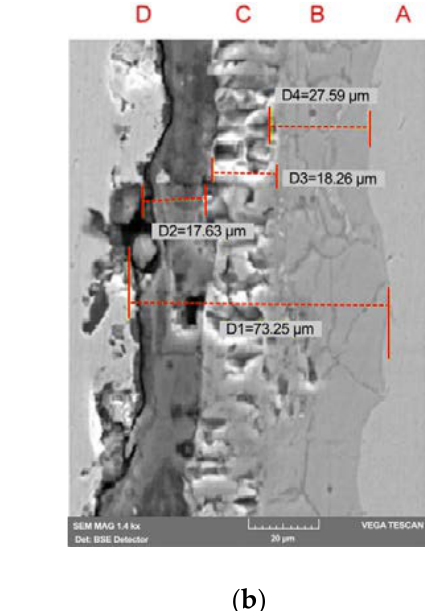
( b ) Figure 7. EDS analysis at selected points in the sample sections: ( a ) S1 sample; ( b ) S2 sample. Table 4. EDS results on selected points in the sample sections. Sample